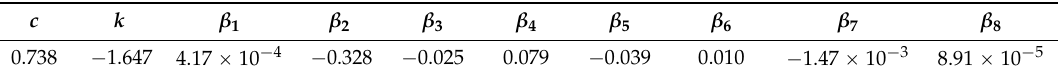
Table 2. Parameters of the aspheric front surface of the inset lens.